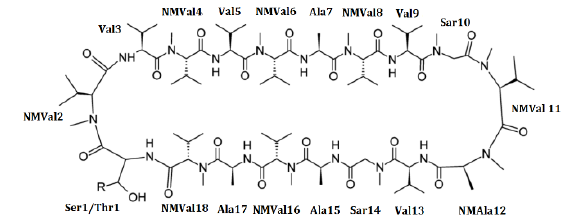
Figure 4. Structure of gymnopeptide A/B